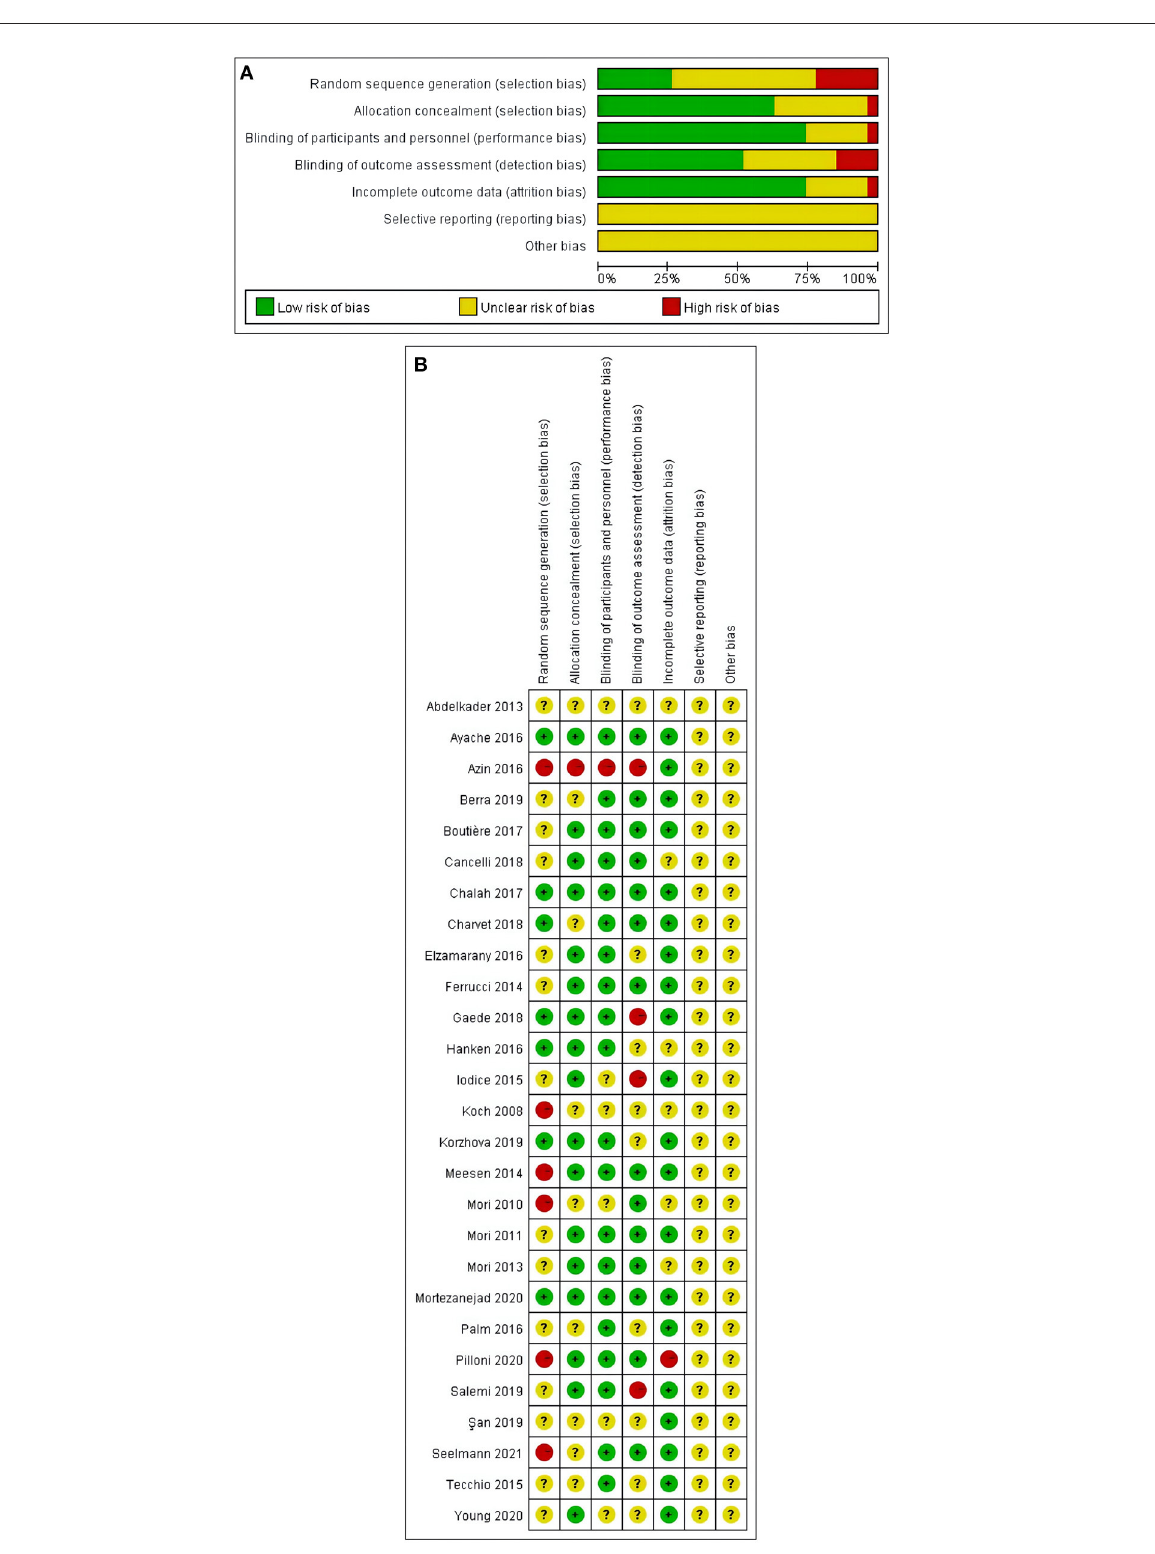
FIGURE2 (A,B) Risk of bias assessment summary according to the Cochrane risk of bias tool: Red, green, and yellow colors indicates high, low, and unclear risk of bias, respectively. (A) Risk of bias summary: review authors’ judgements about each risk of bias item for each included study. (B) Risk of bias graph: review authors’ judgements about each risk of bias item presented as percentages across all included